Question: Summarize what this figure shows in one sentence.
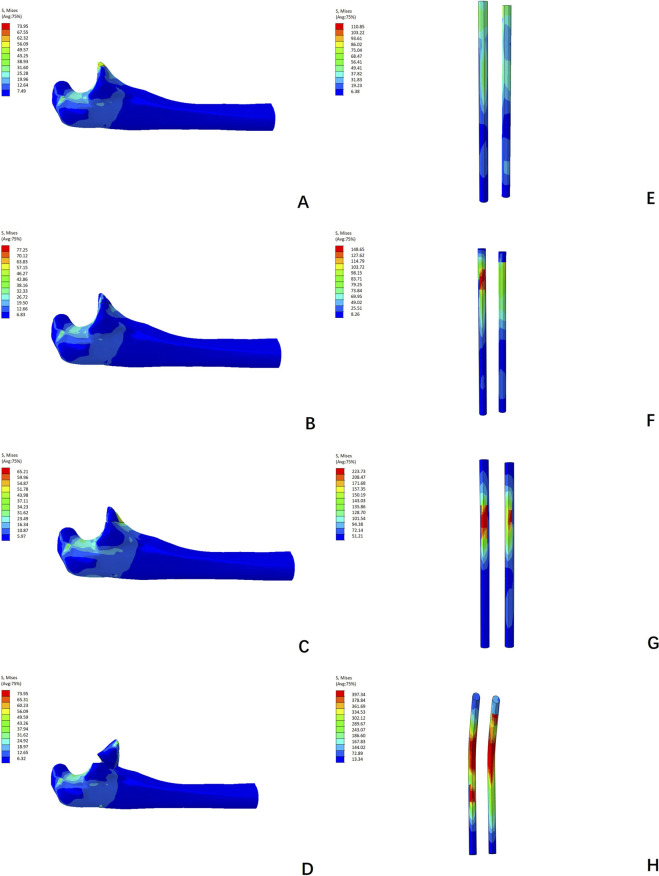
Answer: Von Mises stress distributions of the fracture fragments and K-wires in the horizontal displacement simulation: (A) Von Mises stress distribution of the fracture fragment for the 15% fracture height model. (B) Von Mises stress distribution of the fracture fragment for the 30% fracture height model. (C) Von Mises stress distribution of the fracture fragment for the 45% fracture height model. (D) Von Mises stress distribution of the fracture fragment for the 60% fracture height model. (E) Von Mises stress distribution of K-wires for the 15% fracture height model. (F) Von Mises stress distribution of K-wires for the 30% fracture height model. (G) Von Mises stress distribution of K-wires for the 45% fracture height model. (H) Von Mises stress distribution of K-wires for the 60% fracture height model.